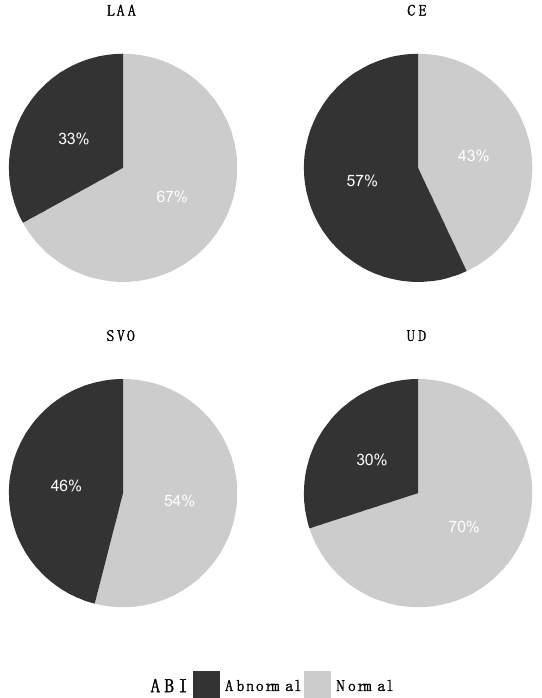
J. Pers. Med. 2022 , 12 , x FOR PEER REVIEW